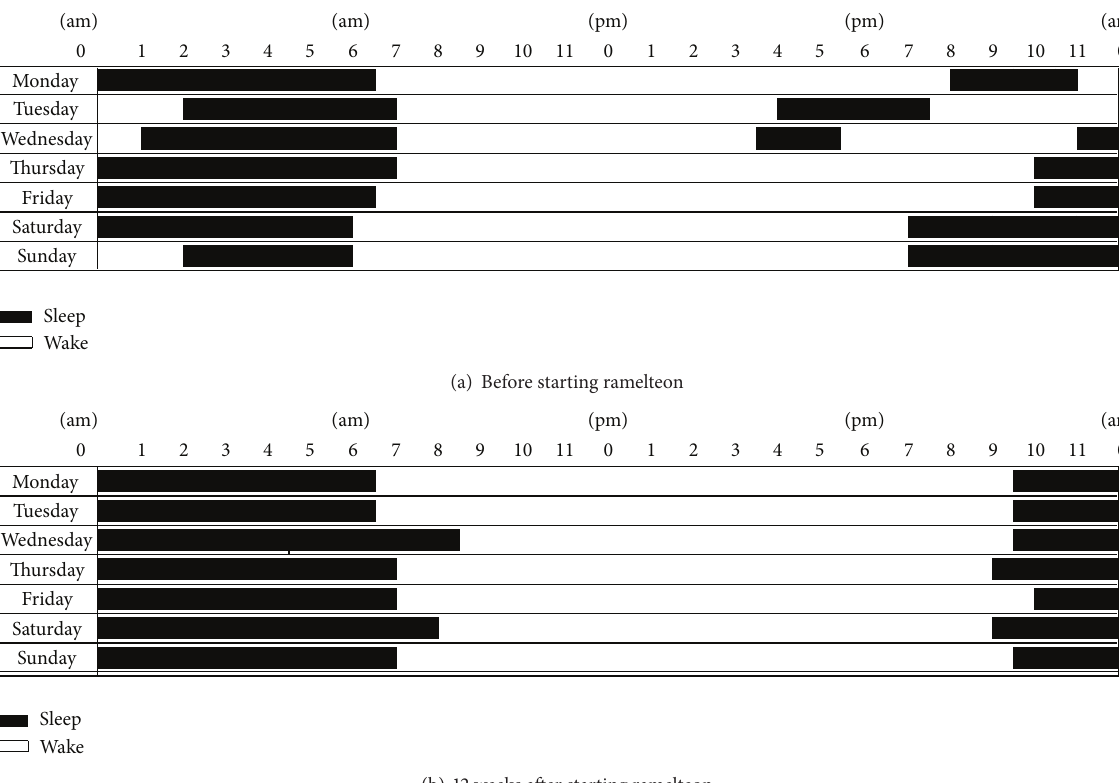
Figure 1: Sleep diaries of Case